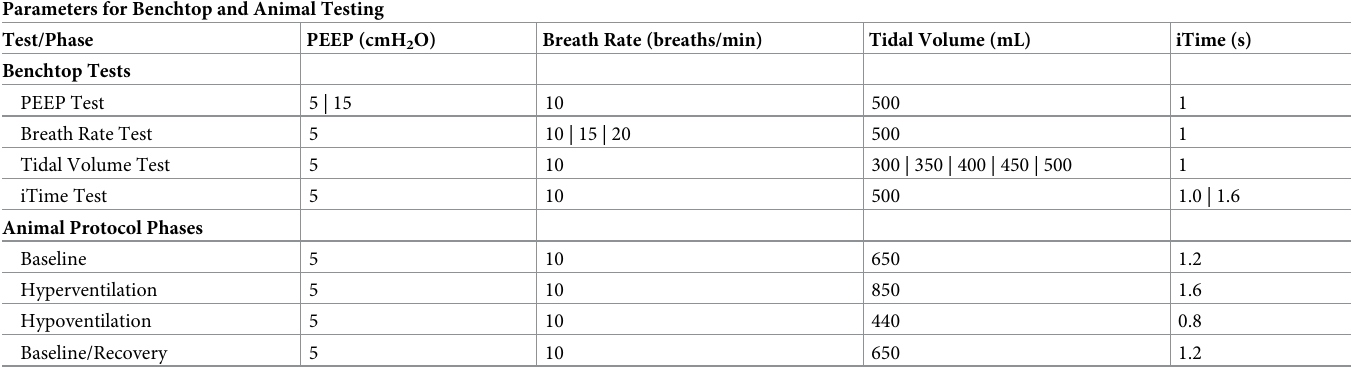
Table 2. Ventilator parameters used for the benchtop testing as required for FDA EUA ventilator requirements as well as the animal ventilation test showing the phases of simulated ventilation treatment. Parameters for Benchtop and Animal Testing